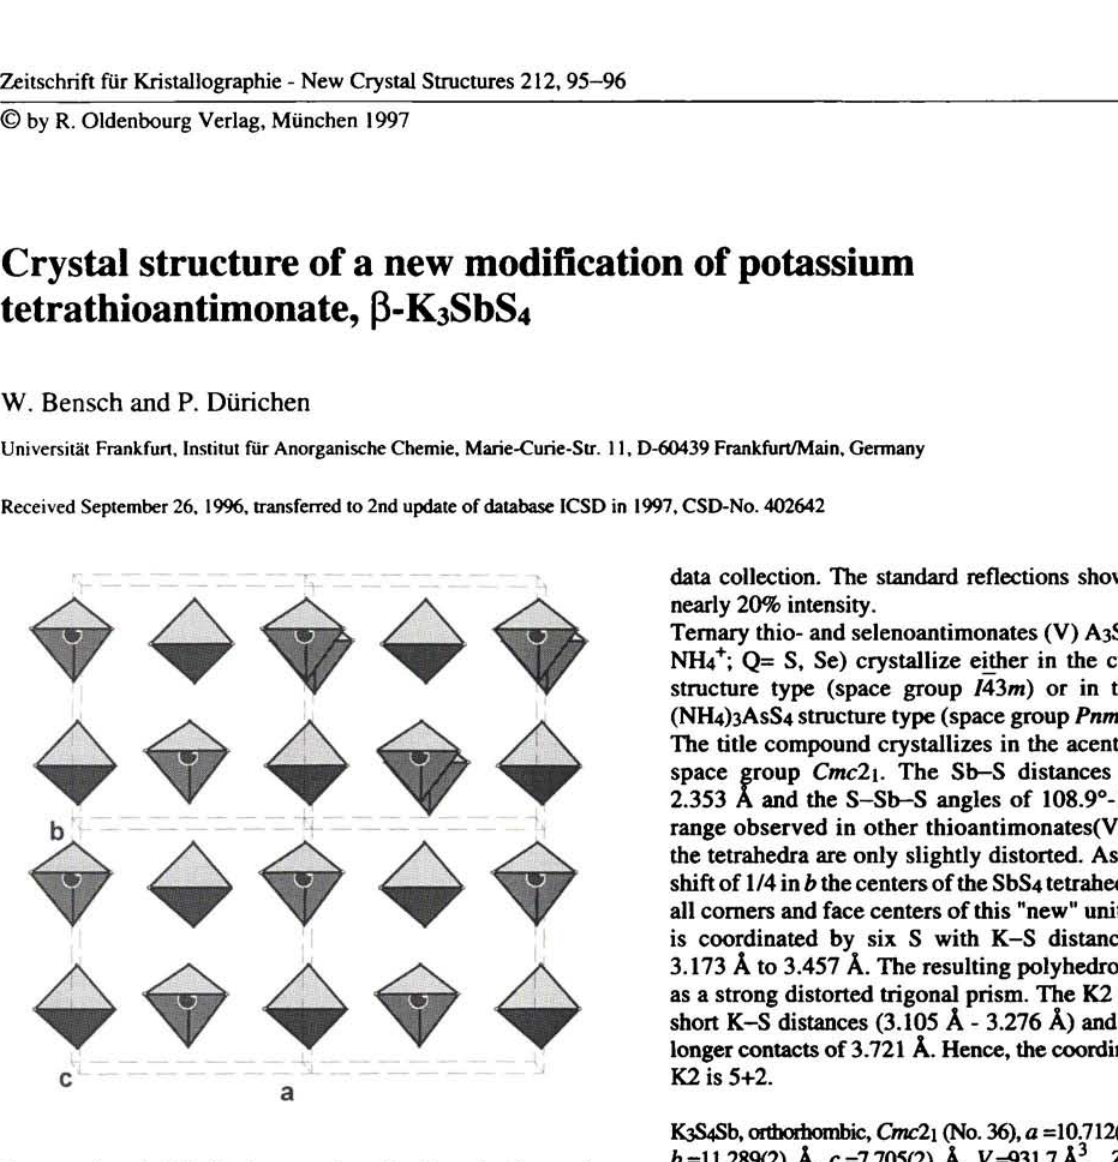
Table 1. Parameters used for the X-ray data collection